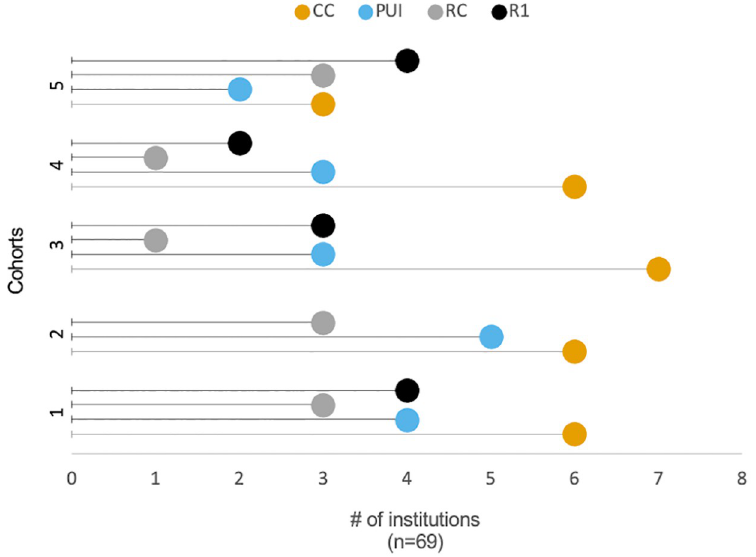
Fig 3. Institutional break down of NW PULSE institutional teams. Five cohorts of institutional teams participated in NW PULSE professional development activities. The diversity of institutions that participated reflects the NW PULSE philosophy of inclusivity and shared interests. (CC: Community Colleges, PUI: Predominantly Undergraduate Institutions, RC: Regional Comprehensive Institutions, R1: Research-intensive Institutions).